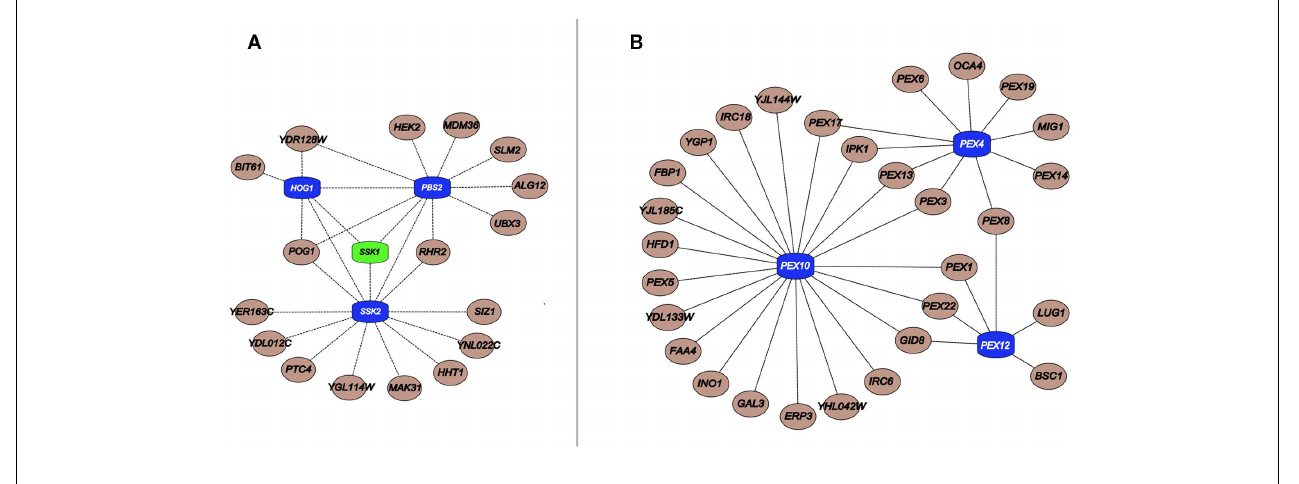
Pex10, and Pex12 (blue). Interactions were obtained from a previous publication integrating chemogenomics data (Venancio et al.,